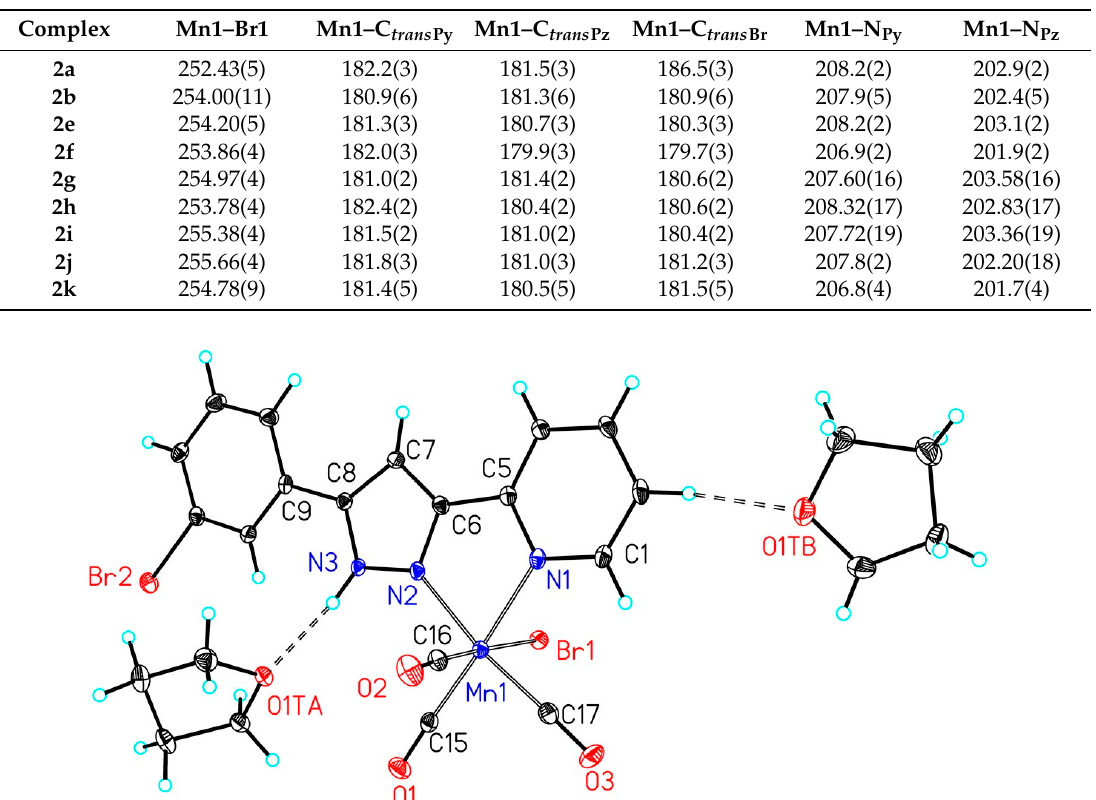
Table 2. Selected bond lengths (pm) of the complexes [(OC) 3 Mn(Br)(2-PyPz R H)] ( 2 ). The group R is bound in 5-position of the bidentate 3-(2-pyridyl)pyrazole ligand (definition of R see Table 1).